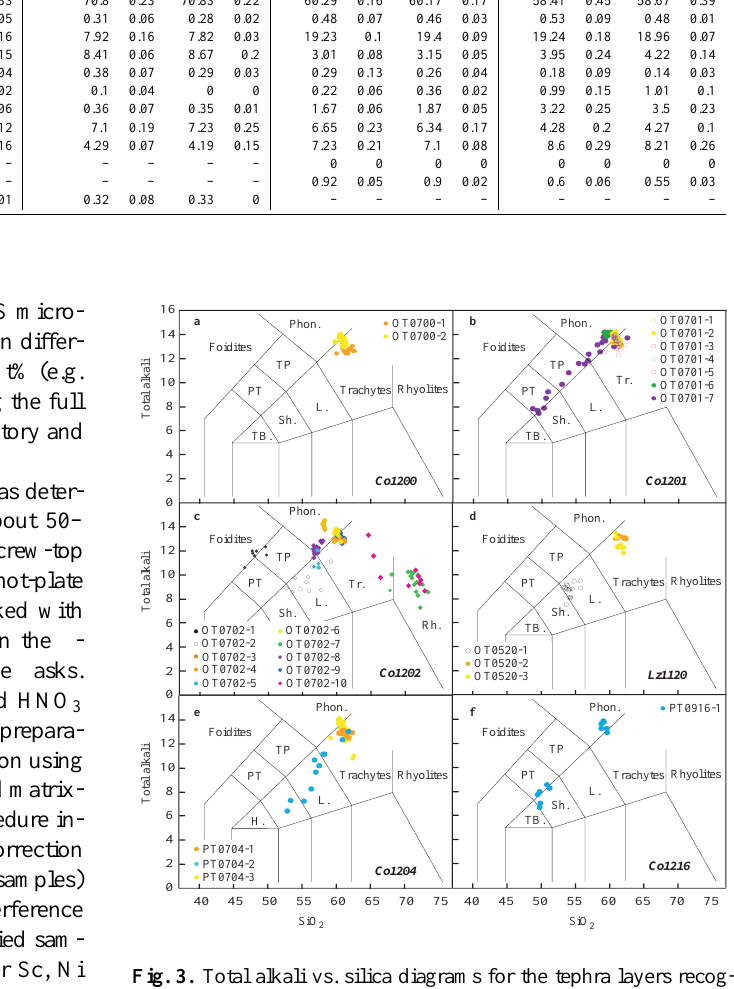
Fig. 3. Total alkali vs. silica diagrams for the tephra layers recog- nised in the six cores studied or reviewed in this